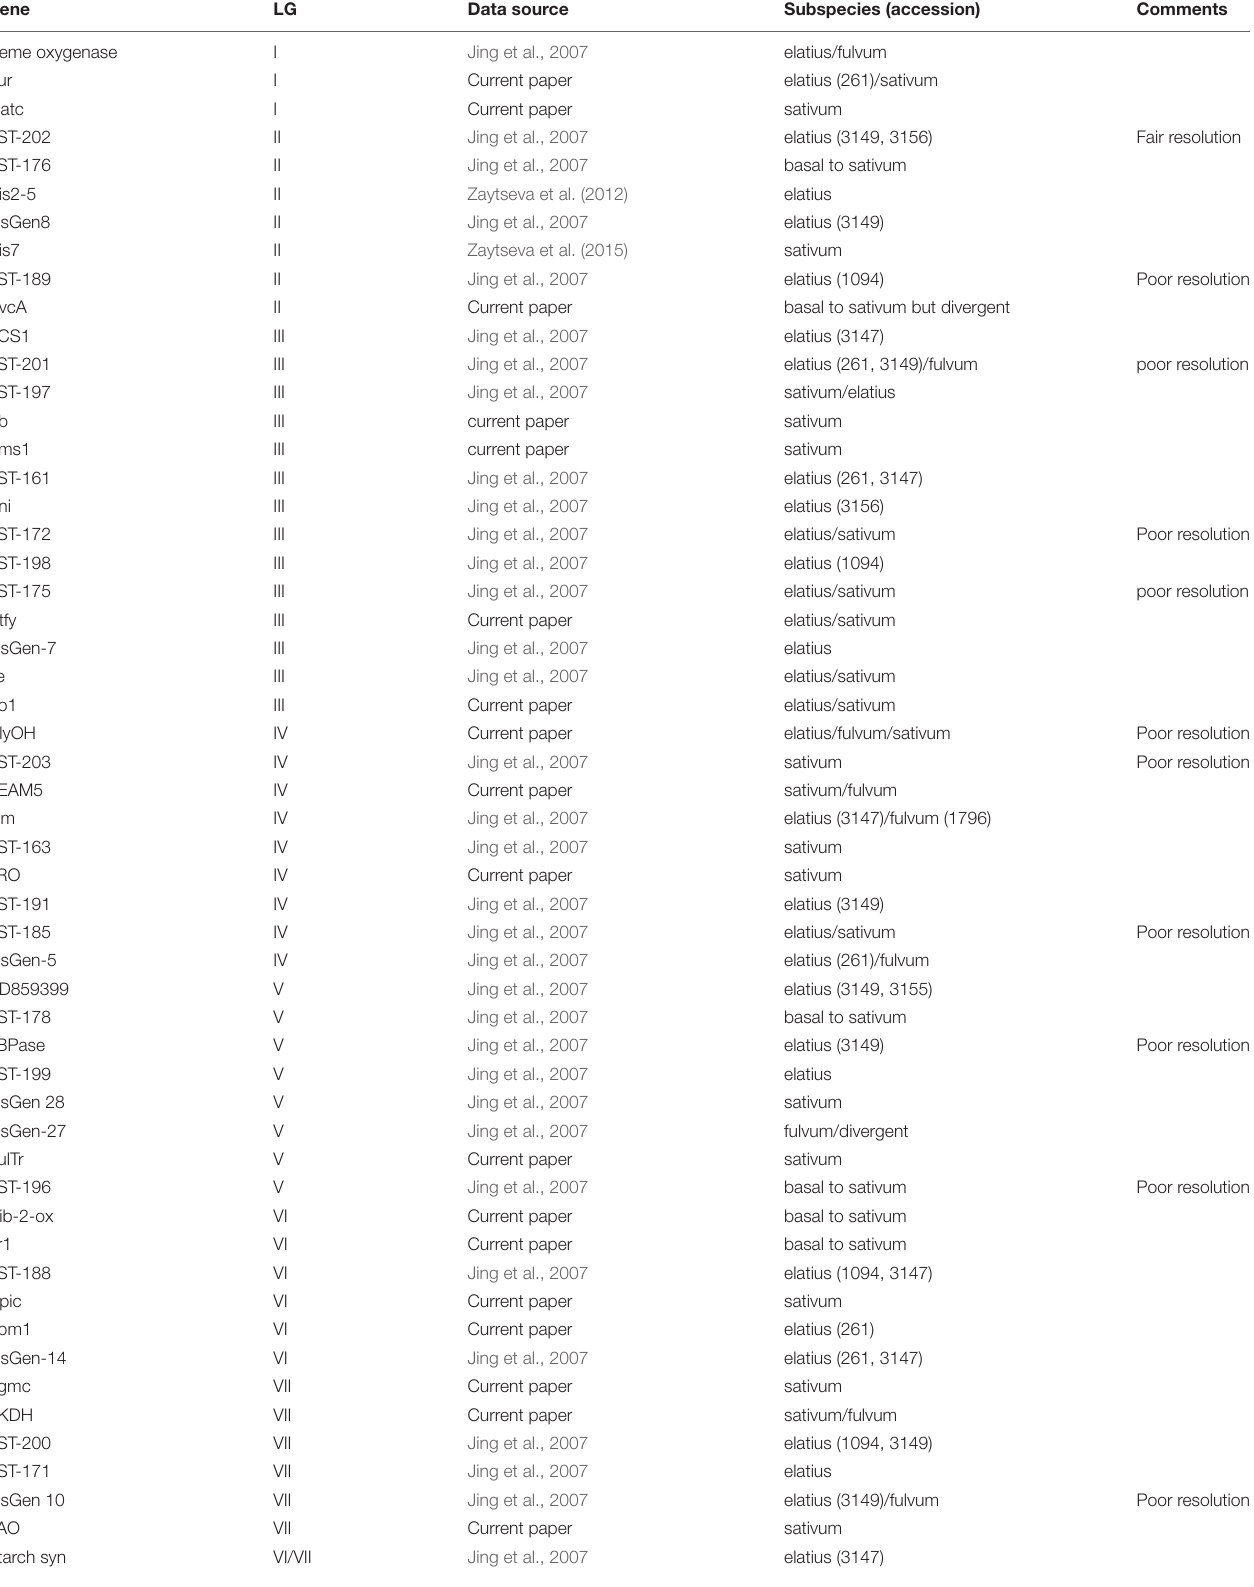
TABLE 1 | Pisum taxon (taxa) with the allele displaying the greatest similarity to the allele in the Abyssinian pea. Gene LG Data